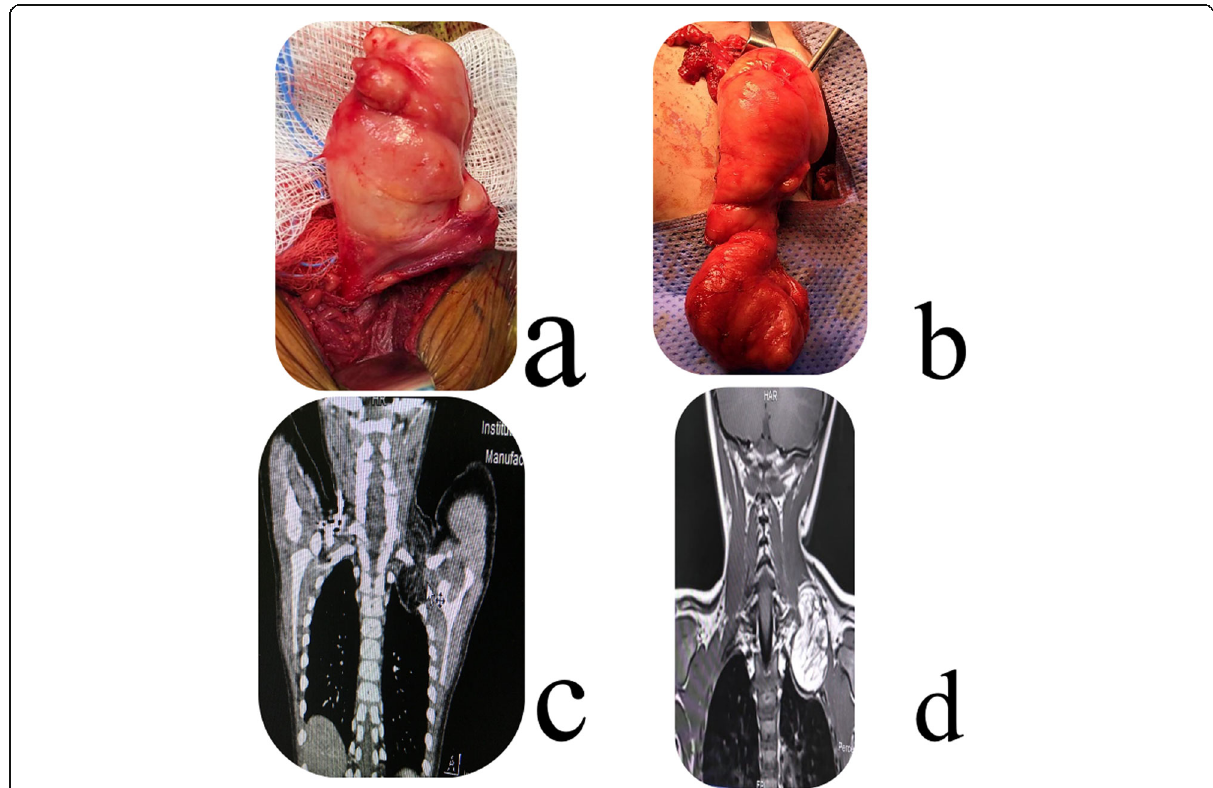
Fig. 4 a Mass delivered to wound. b 11×4×5.5 cm, smooth, lobular, yellow-tan mass, weighed 90 g. c CT neck and chest. d MRI neck and